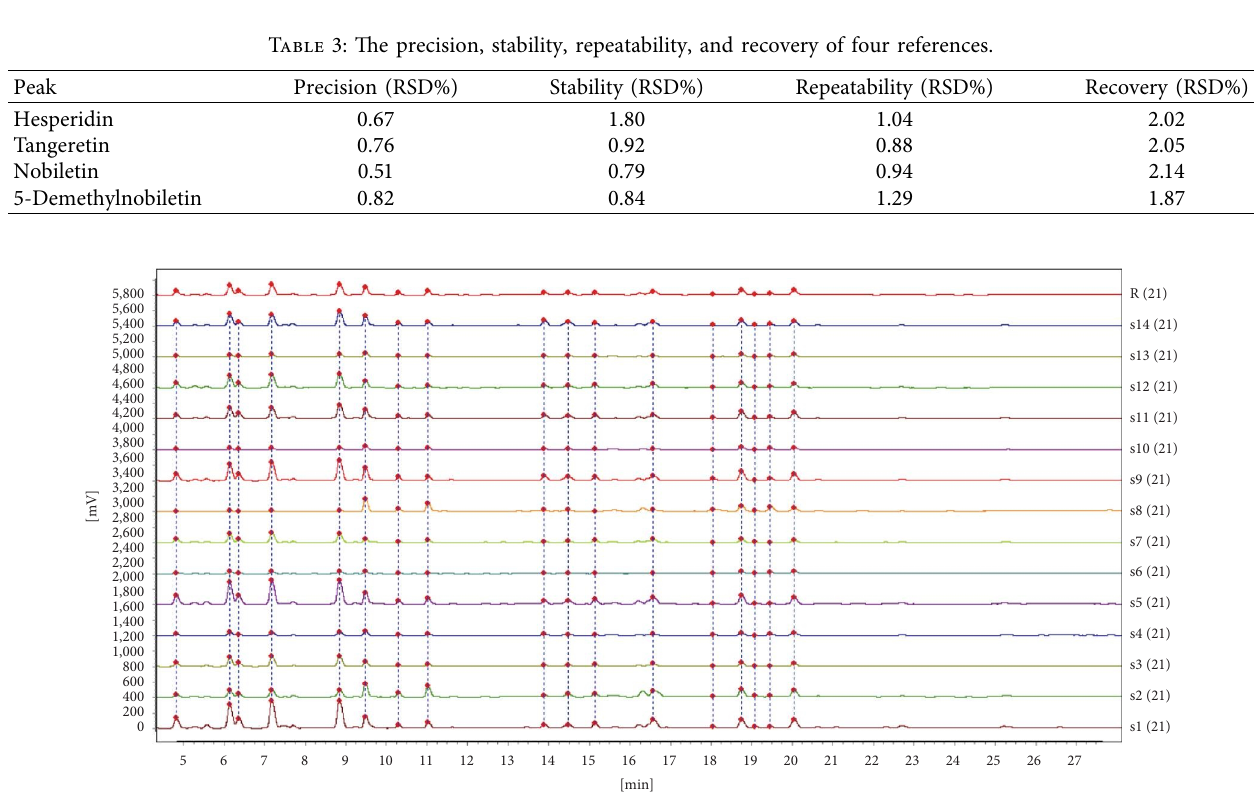
Figure 1: Superimposed chromatograms of 14 batches of CRC leaves.